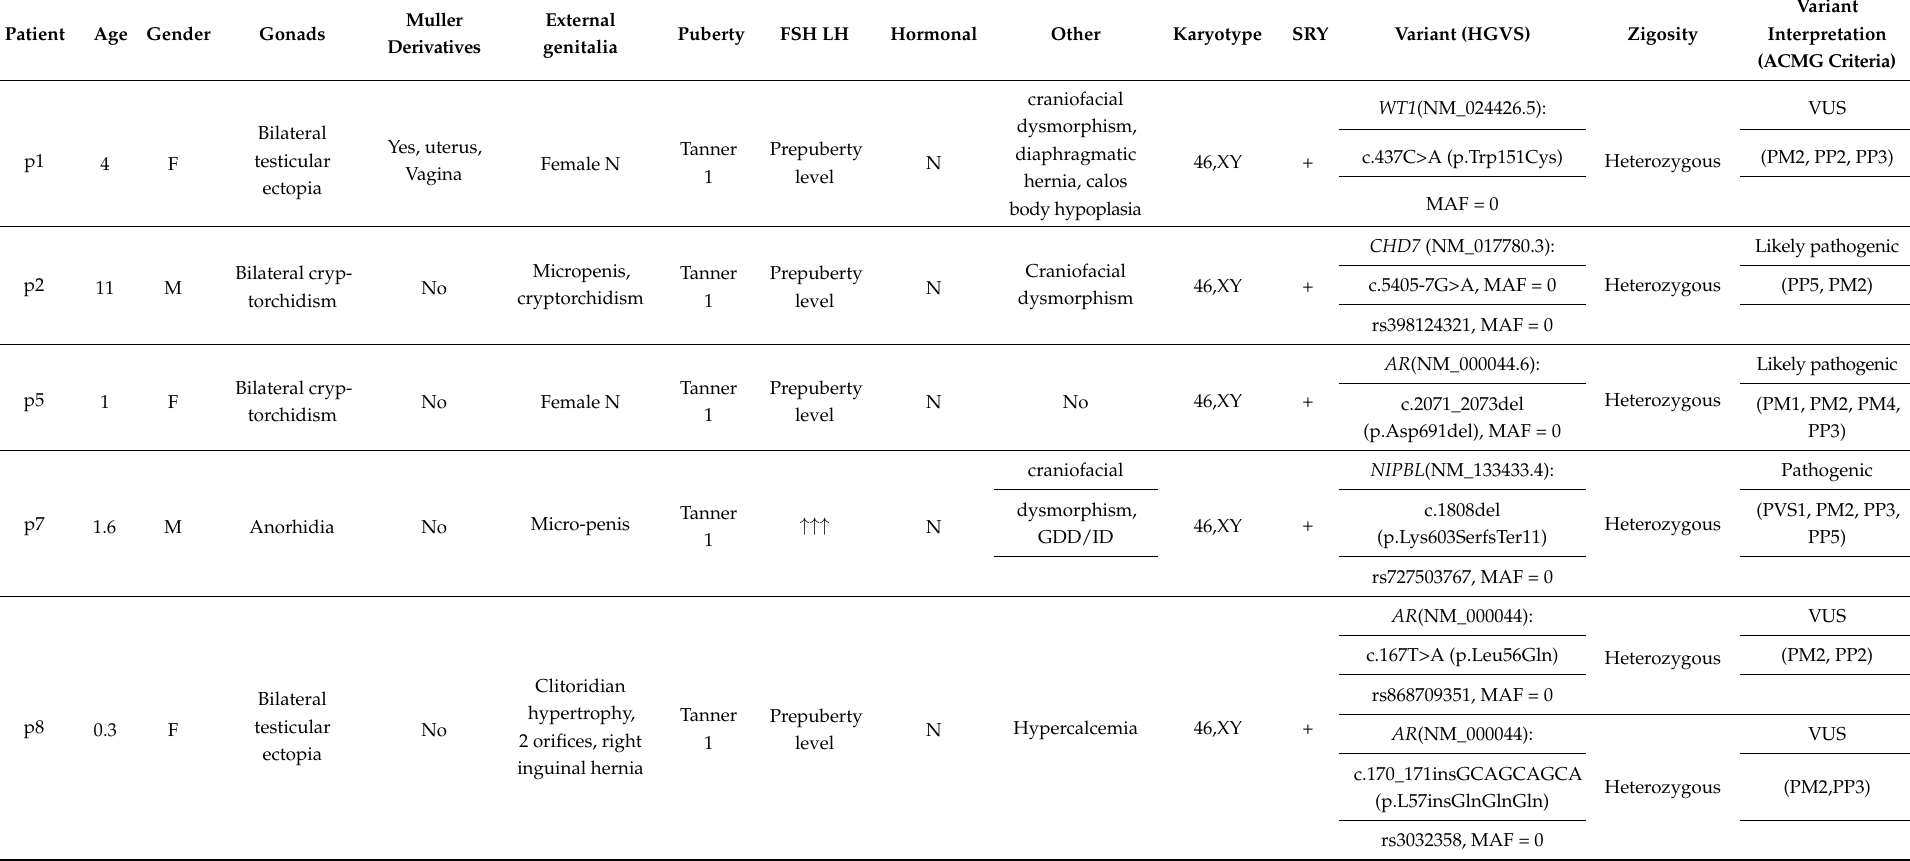
Table 3. Phenotypic and genotypic characterization of patients analyzed by